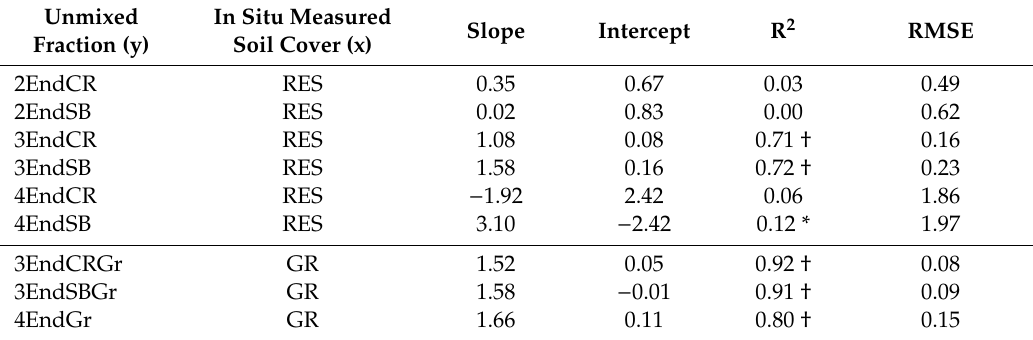
Table 4. Summary of unmixing results estimated using 2, 3, and 4 endmember combinations correlated with in situ measured residue or green cover for image 18 / 30 2016-04-18 ( n = 49).